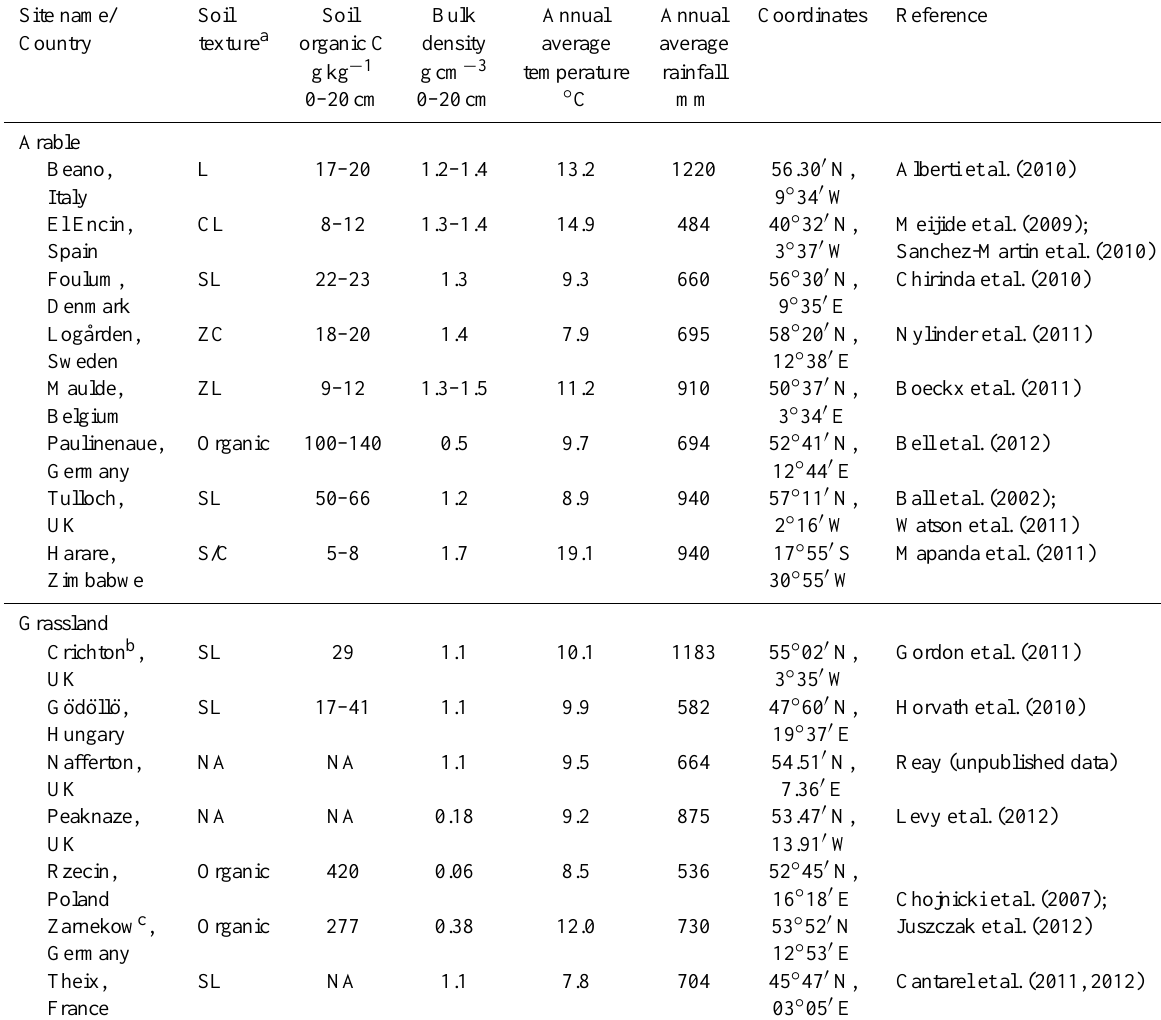
Table 1. An overview of the soil and climatic conditions across the experimental